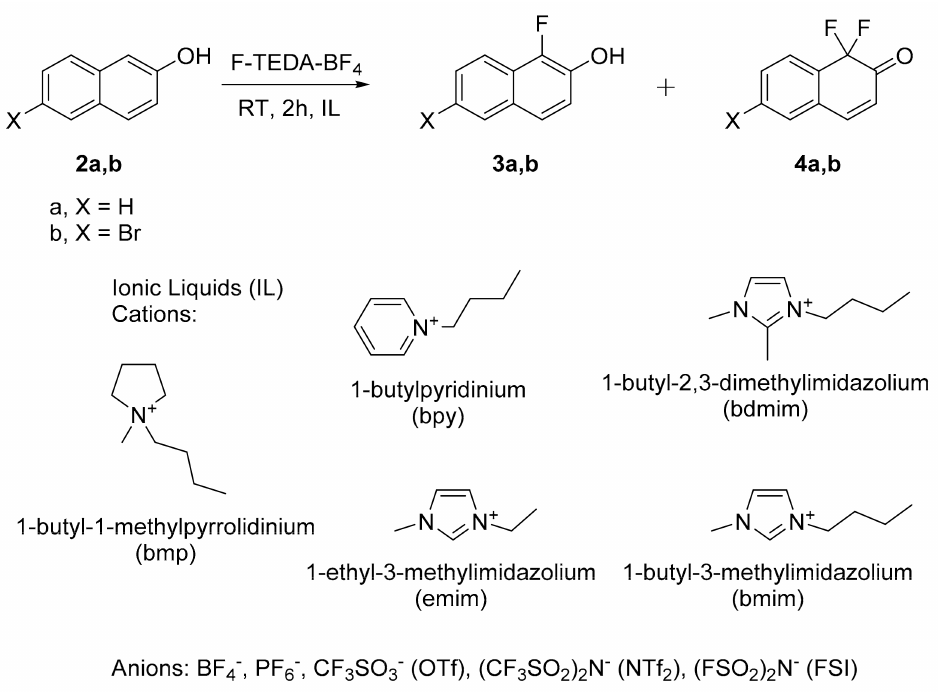
Scheme 2. Mechanochemical electrophilic fluorination of naphthols in the presence of grind- ing